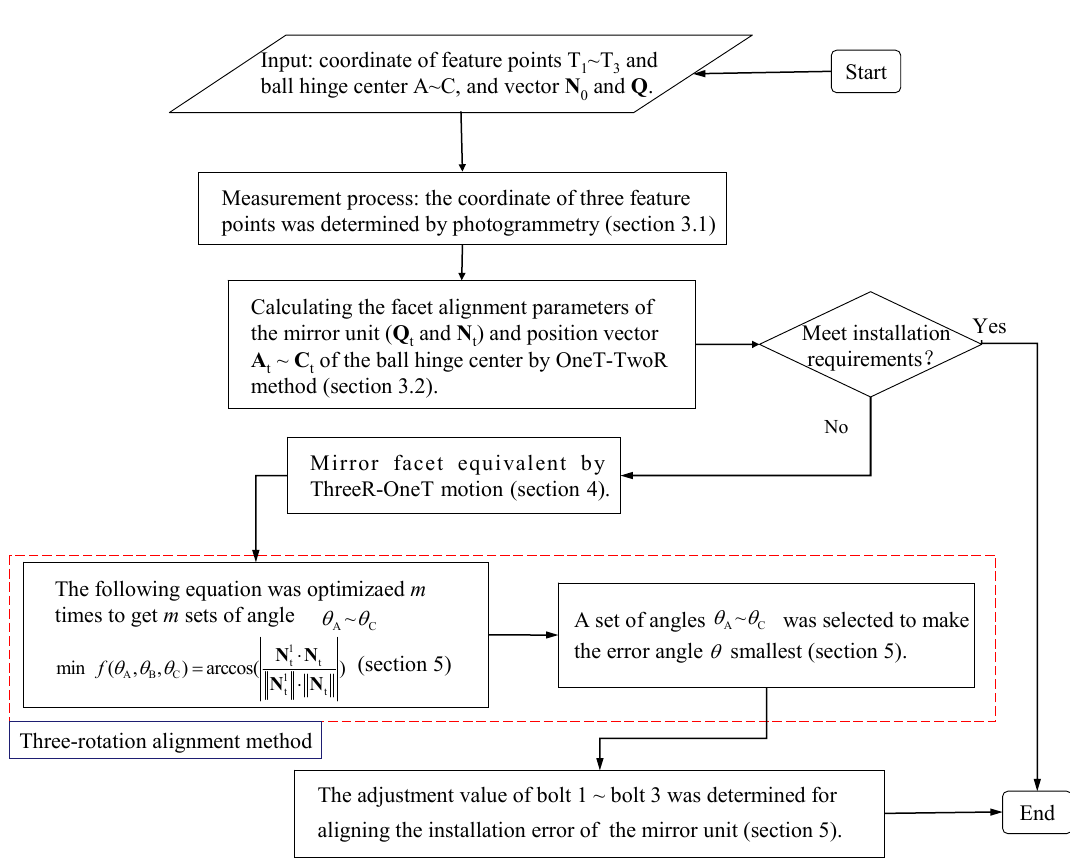
Figure 7. Flowchart of the three-rotation alignment method for aligning the axis vector of single mirror unit in the dish concentrator.